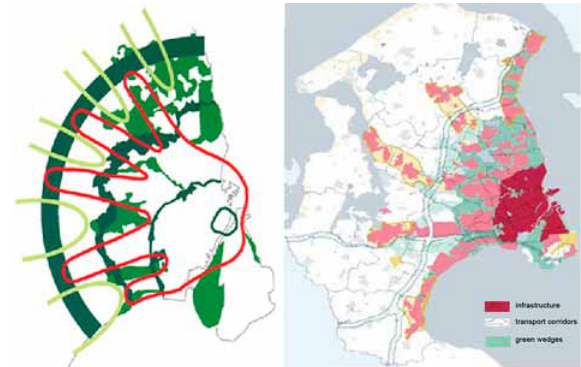
fig. 4. Copenhagen finger Plan. The left part of the figure shows the five fingers, green wedges and greenbelt in Copenhagen, 2007 (the hand shape – the urban fabric and its infrastructure, the wedge shape- green wedges between urban settlements and the arc shape- greenbelt around Copenhagen). on the right the updated plan from 2013 is shown green wedges are between urban settlements and infrastructure and transport corridors (Danish nature